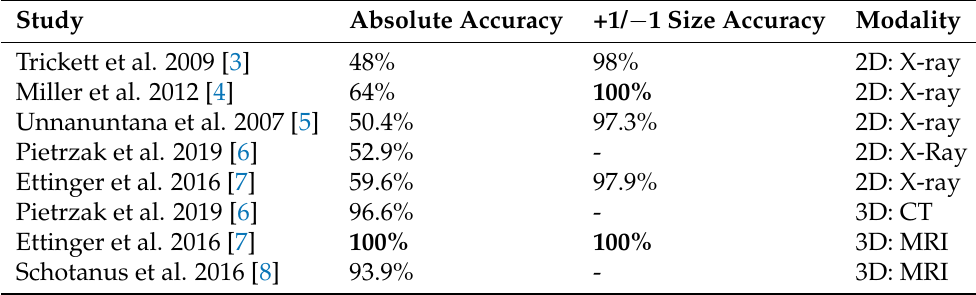
Table 2. Comparison of manual methods for predicting the required femoral implant size in terms of their accuracy. Bold values indicate the best performance per metric.